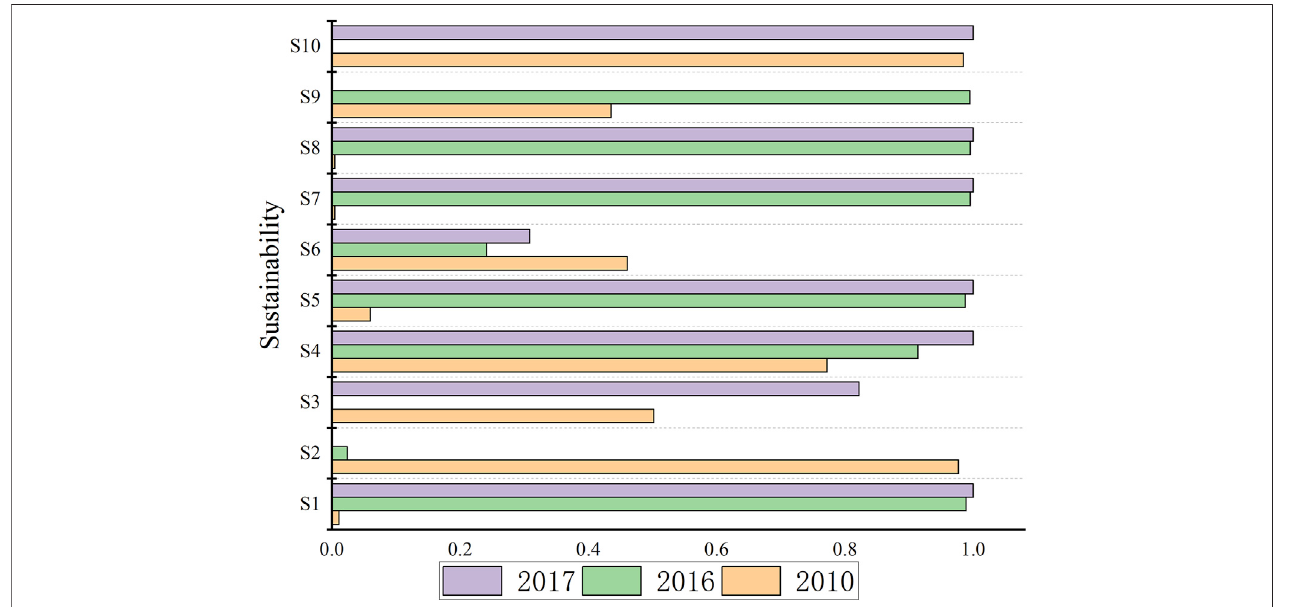
FIGURE 7 | Comparison of sustainability indicator evaluation values in typical